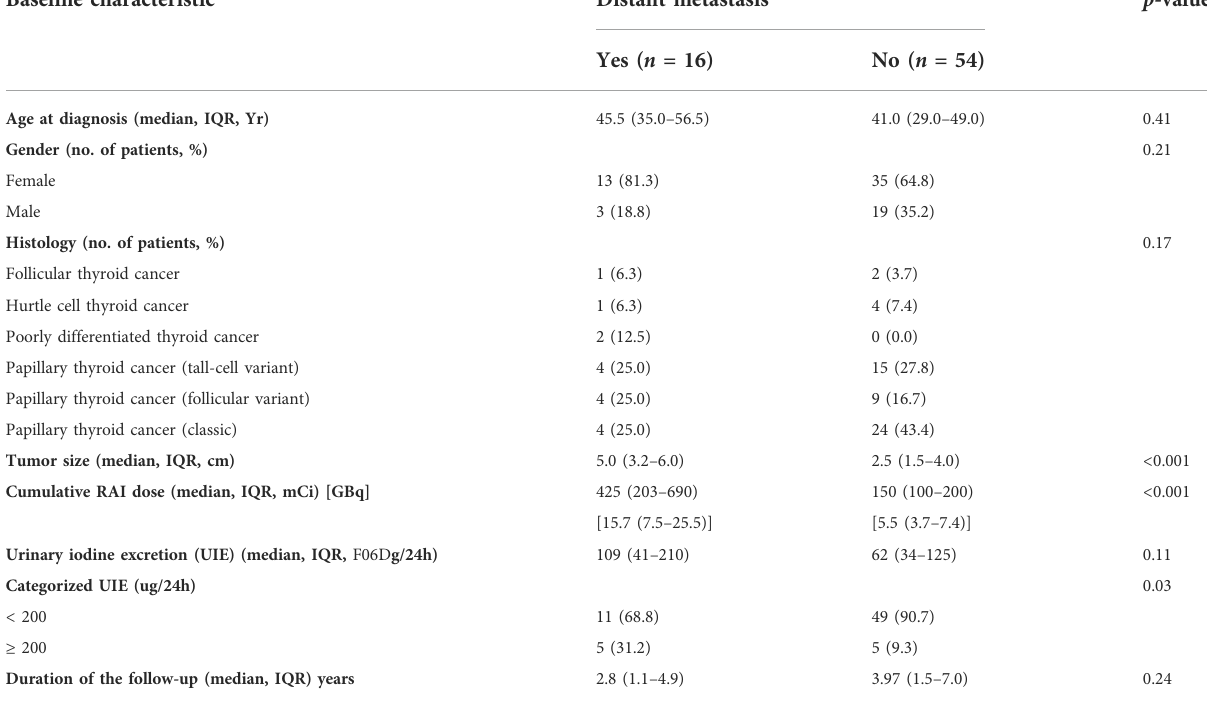
TABLE 4 Patient characteristics strati fi ed by the presence of distant metastasis. Baseline characteristic